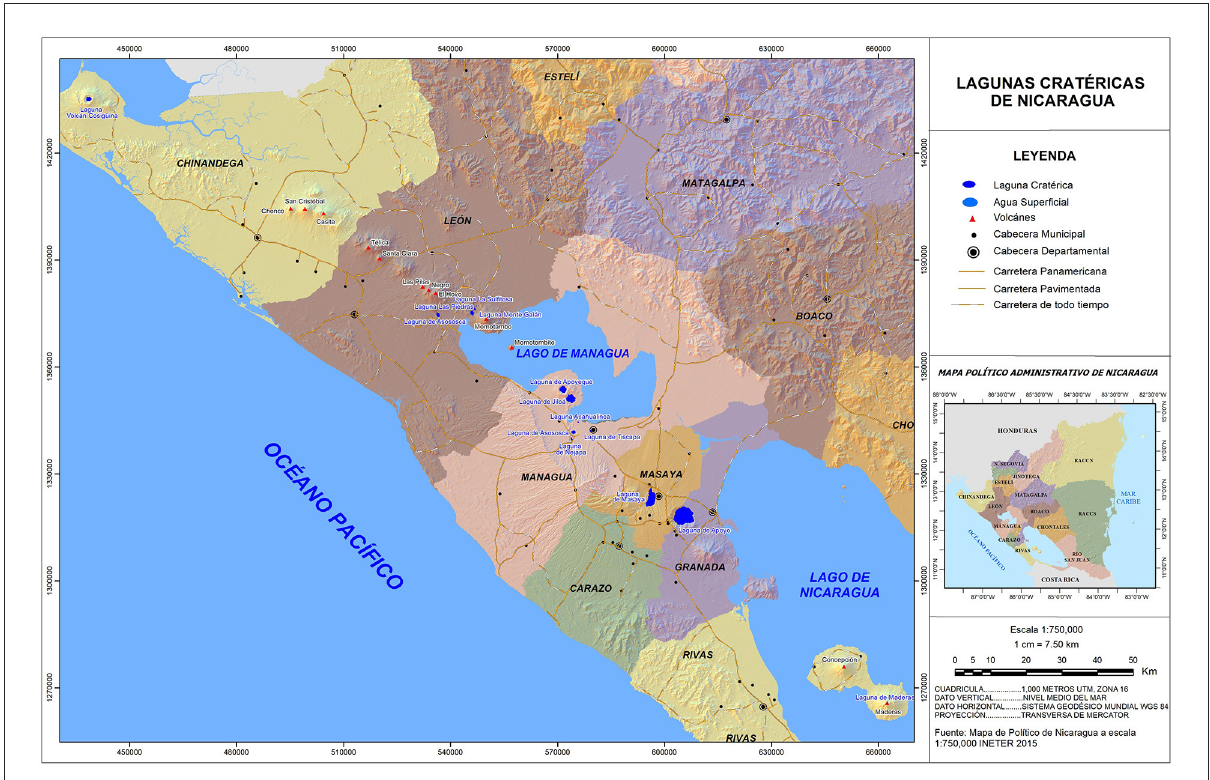
FIGURE3 Map of crater lakes and volcanic chain. Prepared by authors with official information of